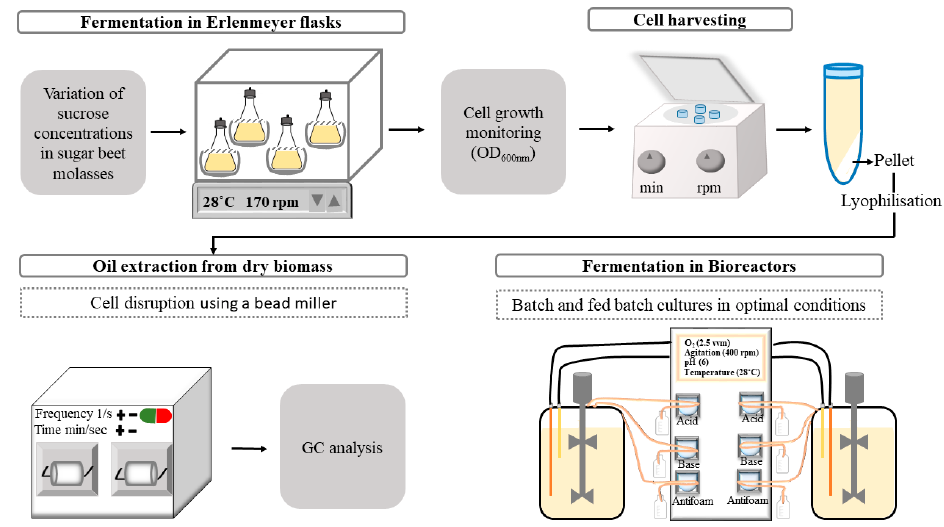
Figure 1. Experimental set-up for the production of OCFAs in Y. lipolytica .